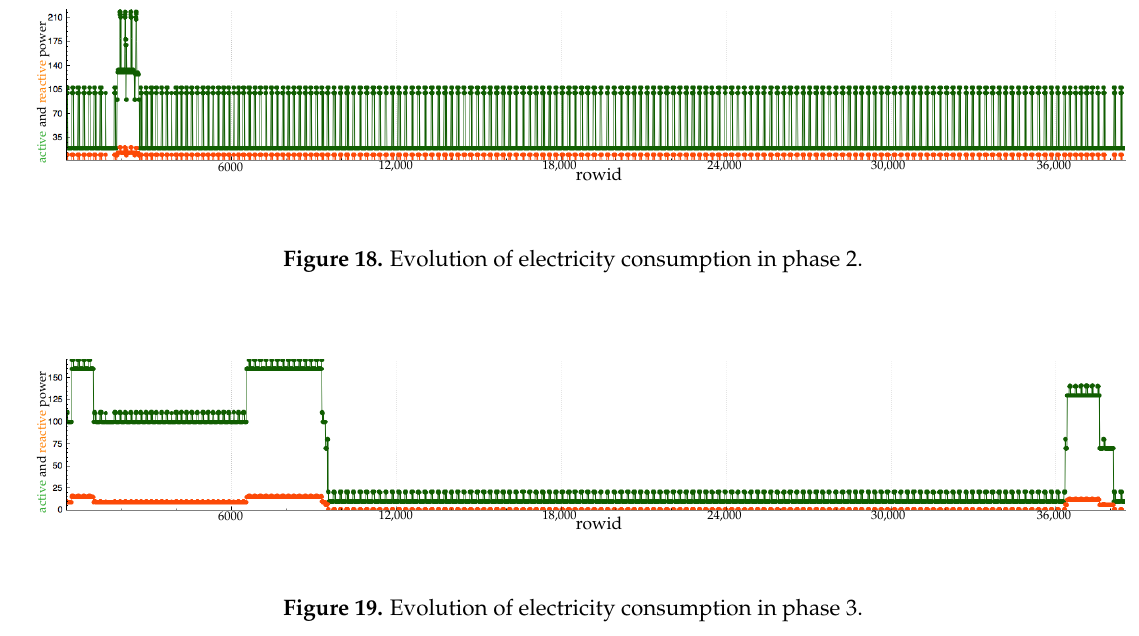
Figure 19. Evolution of electricity consumption in phase